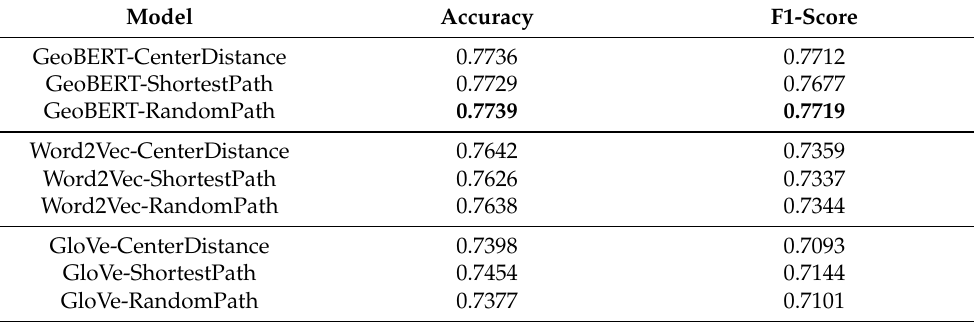
Table 10. Evaluation on working \ living area